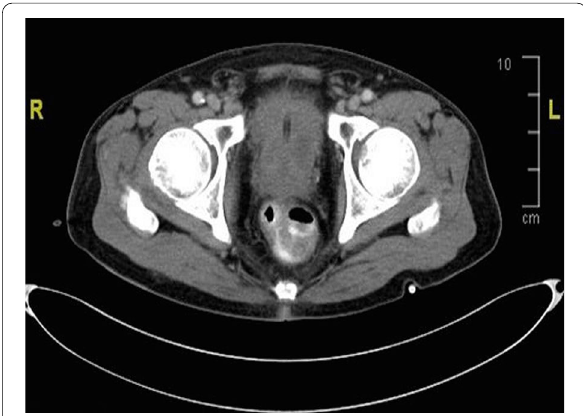
Fig. 4 CT of the pelvis showing a locally invasive prostate